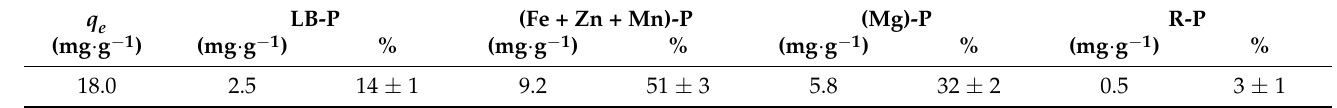
Table 7. Chemical forms of phosphate extracted from loaded Mn 2+ /Zn 2+ /Fe 3+ /Mg-Al-LDH